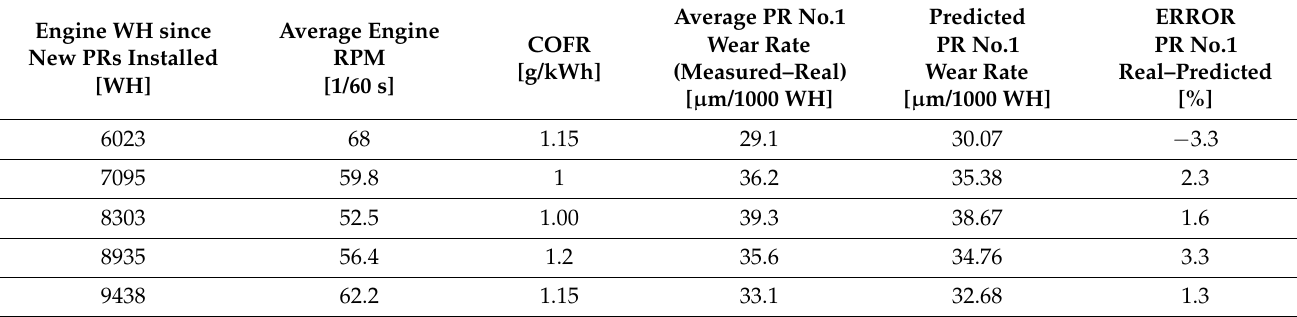
Table 4. Results of the PR wear ratio prediction model verification obtained for PR